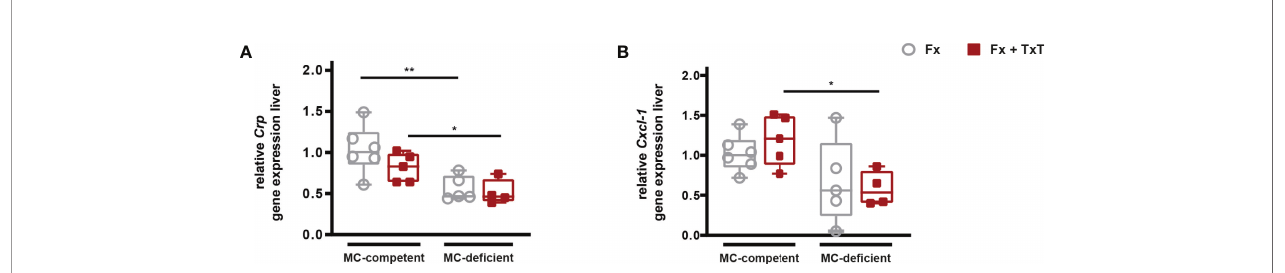
FIGURE 2 | Hepatic acute-phase reaction in mast cell (MC)-competent and MC-de fi cient mice 3 h after fracture (Fx) and combined fracture and thoracic trauma (Fx+TxT). Relative gene expression of (A) C-reactive protein ( Crp ) and (B) C-X-C motif chemokine ligand 1 ( Cxcl-1 ) in the liver. Relative gene expression was calculated by normalizing to the house keeping gene Gapdh . Gray boxes represent Fx mice, red boxes represent Fx + TxT mice. Data are shown as box-and- whisker plots (with median and interquartile range) from maximum to minimum, showing all data points. *p<0.05; **p<0.01. The p values were determined using one- way ANOVA with post hoc Fisher ’ s LSD.